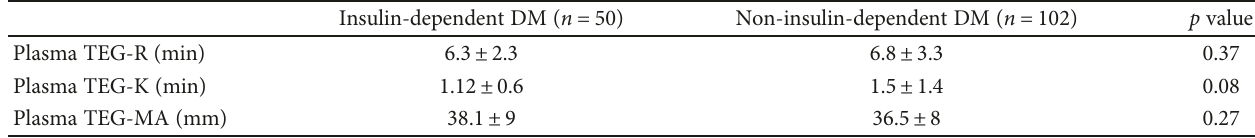
Table 3: Thrombelastography: insulin-dependent versus non-insulin-dependent diabetes